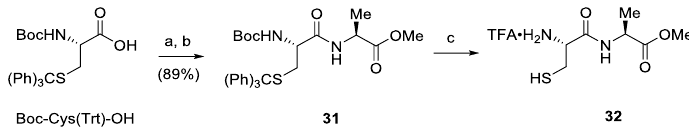
Scheme 9. Preparation of stereochemically pure Cys-Ala-OMe.